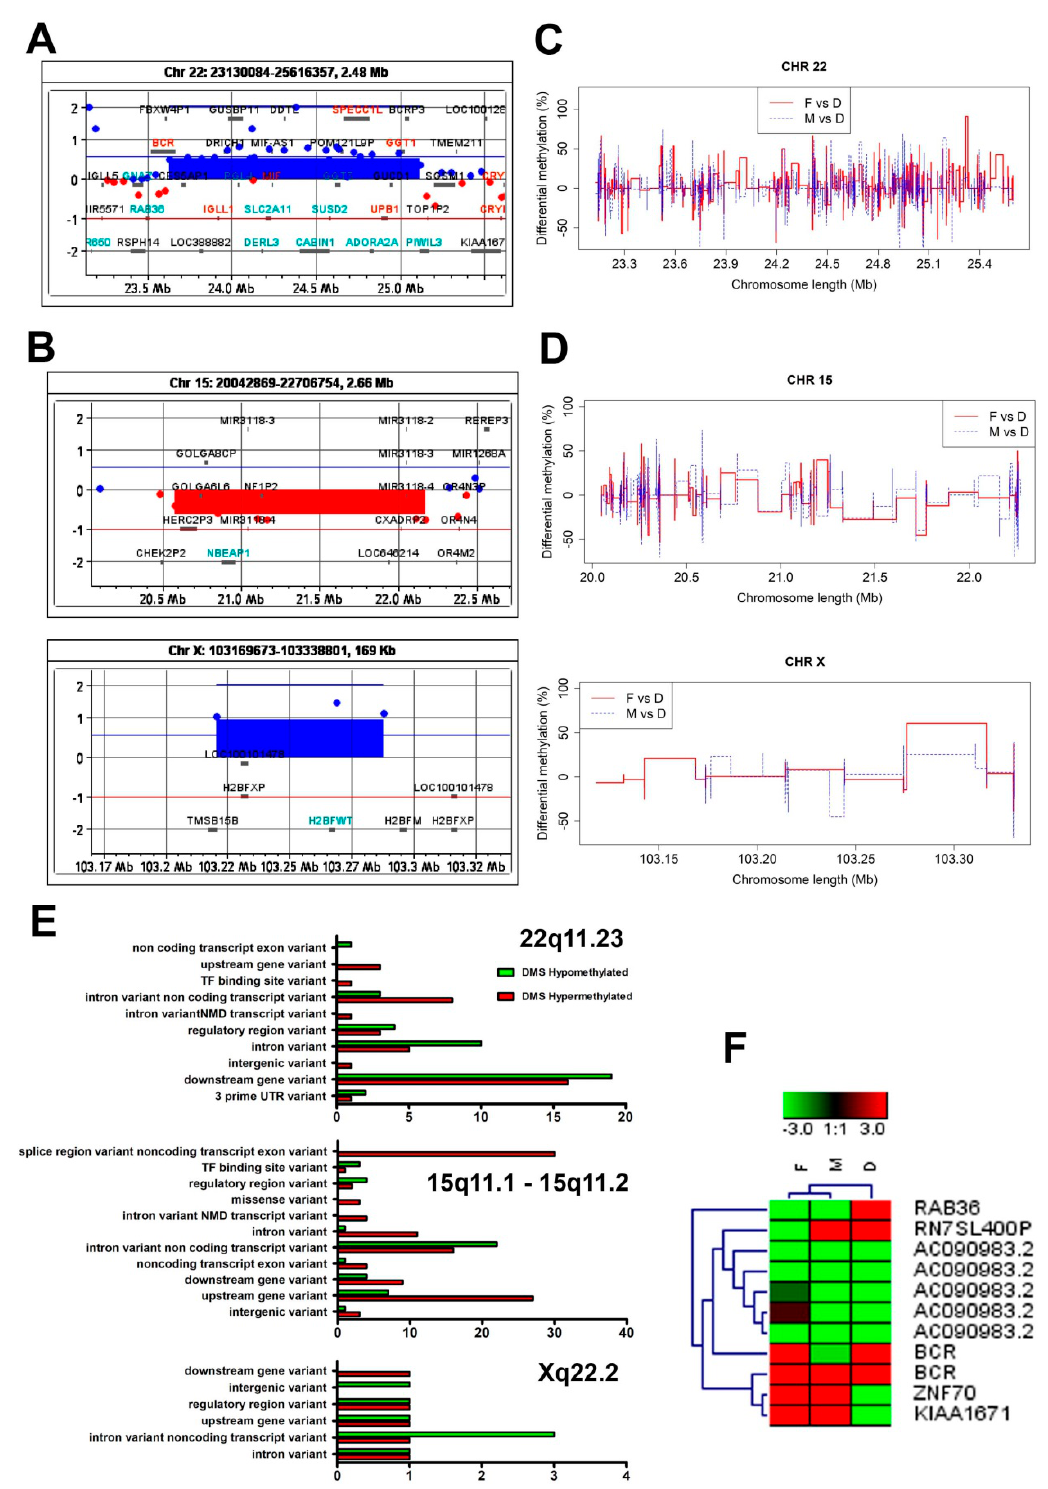
Figure 3. Comparative analysis of the methylation status of chromosomal regions that were subjected to copy number variation in the father’s, mother’s and daughter’s karyotypes. ( A ) An amplification at the q11.23 chromosomal region (a chromosomal gain) on the mother’s chromosome 22 (22q11.23) included the following genes: BCR , CES5AP1 , ZDHHC8P1 , LOC101929374 , LOC388882 , IGLL1 , DRICH1 , GUSBP11 , RGL4 , ZNF70 , VPREB3 , C22orf15 , CHCHD10 , MMP11 , SMARCB1 , DERL3 , SLC2A11 , MIF-AS1 , MIF , GSTT2B , GSTT2 , DDTL , DDT , GSTTP1 , LOC391322 , GSTT1-AS1 , GSTT1 , GSTTP2 , CABIN1 , SUSD2 , GGT5 , POM121L9P , SPECC1L , SPECC1L , ADORA2A , ADORA2A , ADORA2A-AS1 , UPB1 , GUCD1 , SNRPD3 , GGT1 , LRRC75B , BCRP3 , POM121L10P , PIWIL3. ( B ) A loss at the q11.1-11.2 (a chromosomal microdeletion) region on the